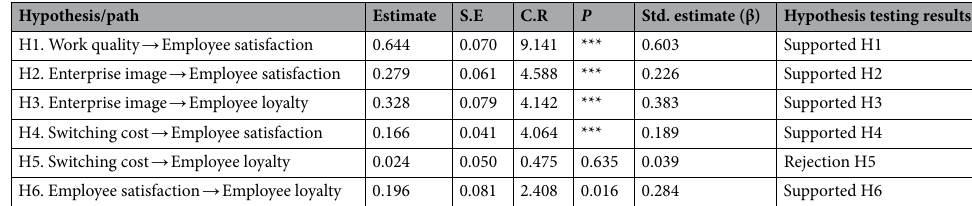
Table 6. Results of the significance test of the model and hypothesis testing. Estimate = Unstandardized regression weights; Std. Estimate (β) = standardized regression weights; S.E. = Standardized error; C.R. = Critical ratio ( >|1.96|). *** = Significance at the 0.001